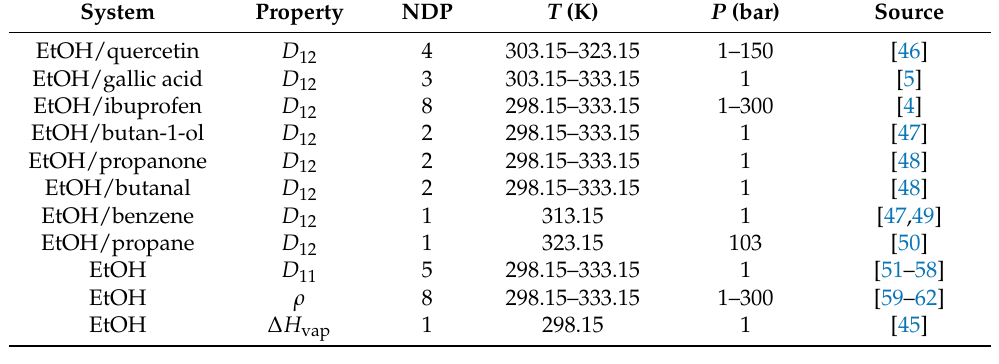
Table 5. Experimental properties studied for binary (ethanol/solute) or unary (ethanol) systems, number of data points (NDP), temperature ( T ) range, pressure ( P ) range, and data sources. System